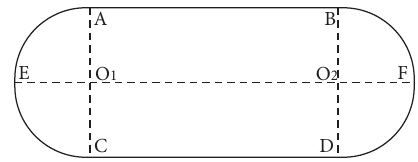
Figure 2: Cross section of the quasirectangle